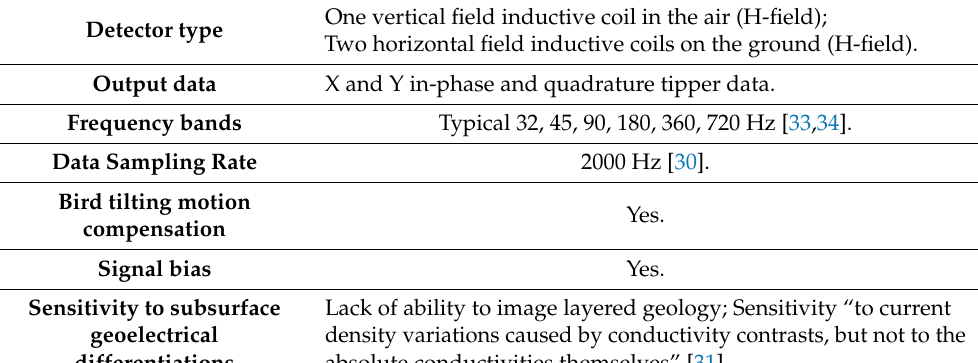
Table 2. Technical specifications of the ZTEM system.